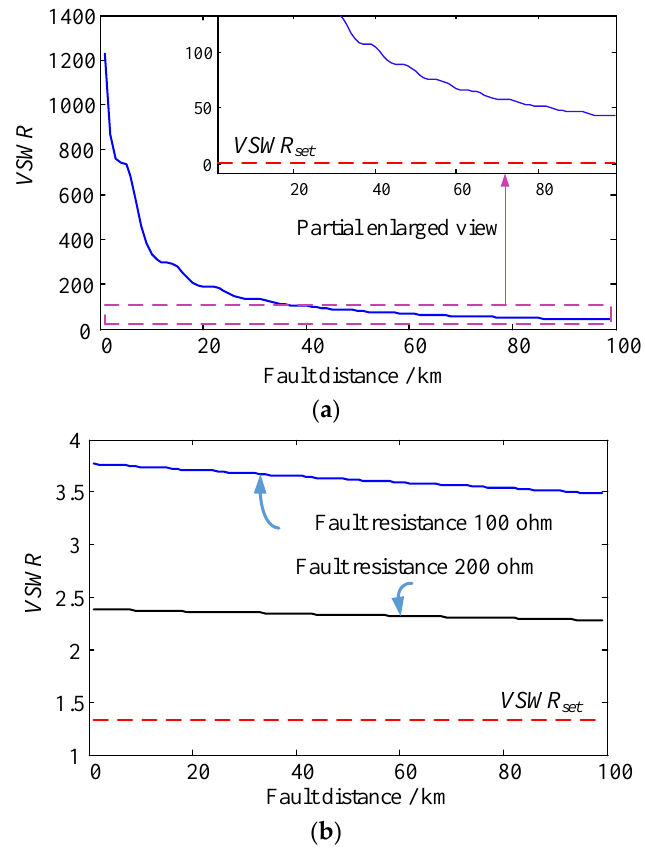
Figure 9. The VSWR for different fault position of double-line earth fault with matched terminal resistor. ( a ) the transition resistance is 0.1 Ω; ( b ) the transition resistance are 100 Ω and 200 Ω, respectively.